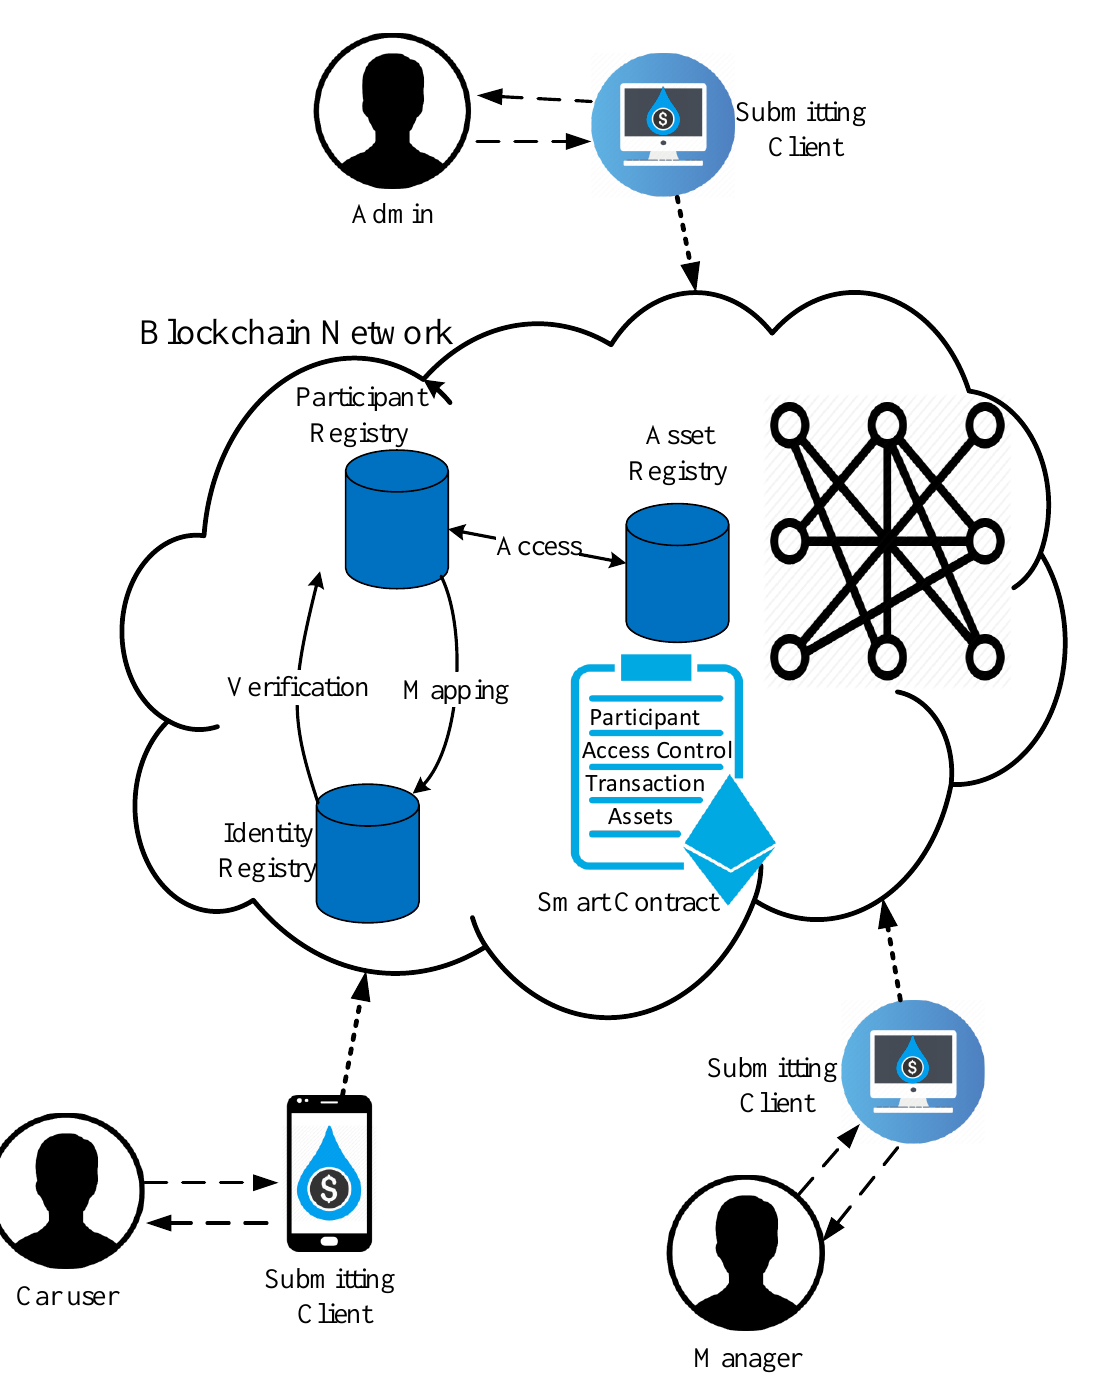
Figure 3. Proposed refueling service interaction